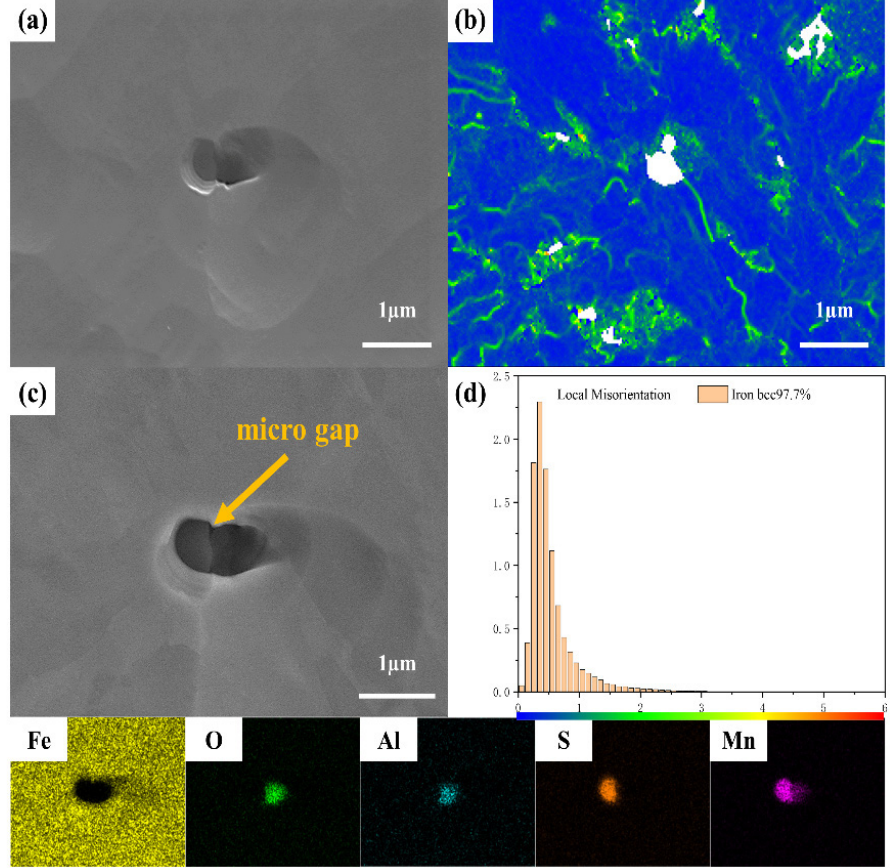
Figure 2. Analysis of Al 2 O 3 inclusions and adjacent areas: ( a ) FE-SEM of EBSD; ( b ) KAM map of the same region shown in ( a ); ( c ) FE-SEM-EDS image; ( d ) the density of the local plastic deformation of